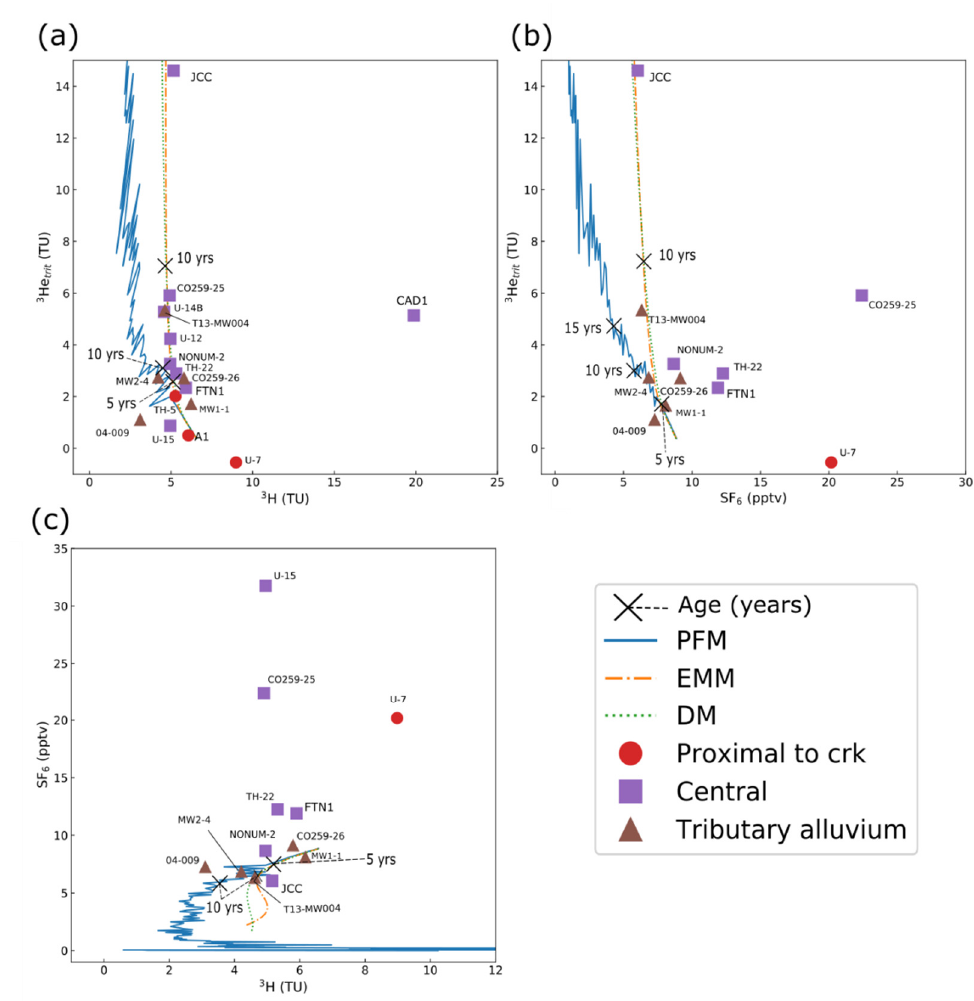
Figure 7. Selected results of lumped parameter modeling: ( a ) 3 He trit versus 3 H, ( b ) 3 He trit versus SF 6 , and ( c ) SF 6 versus 3 H. Ages are marked by symbols along lines for piston-flow model (PFM), exponential-mixing model (EMM), and dispersion model (DM).